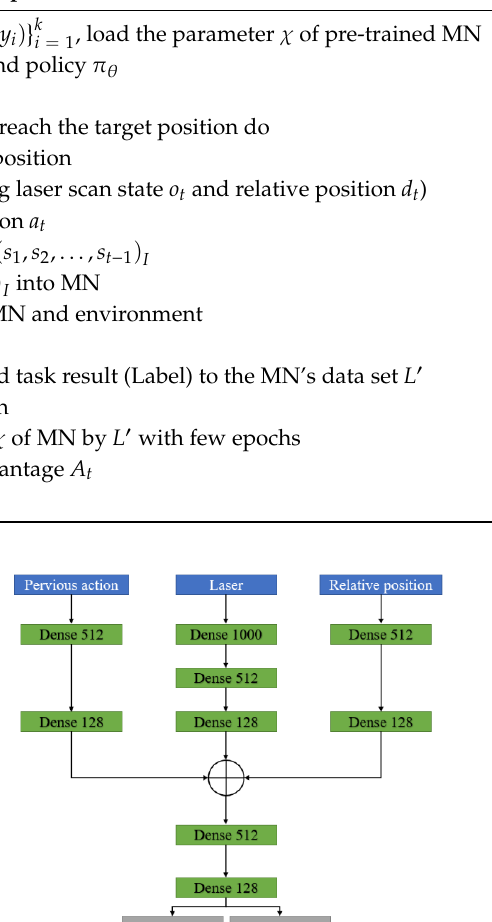
Algorithm 2. Proximal Policy Optimization (PPO) with Pre-Trained MN Reward